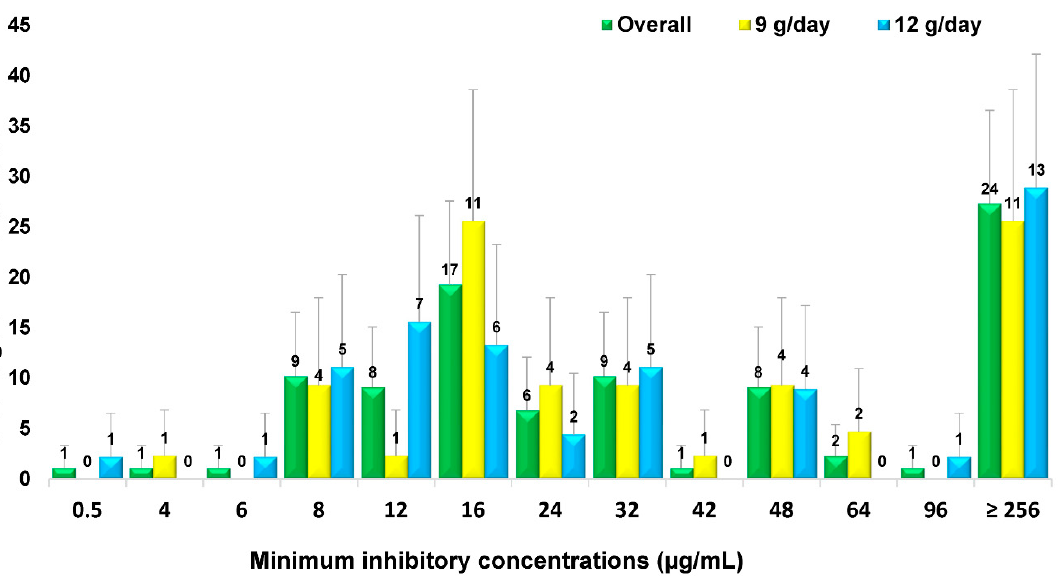
Figure 2. Distribution of sulbactam MIC for XDRAB. The value labels indicate the number of isolates. Error bars indicate the 95% confidence interval.